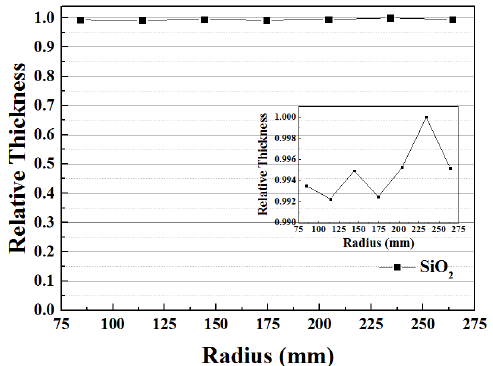
Figure 7. Relative thickness of SiO 2 thin film deposited on a large substrate with a radius of 275 mm.